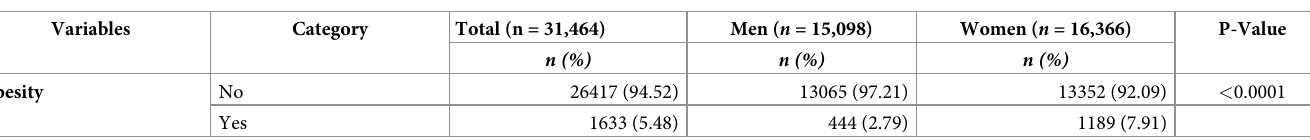
women had multimorbidity, while only 22% of men had multimorbidity. The prevalence of depression in older men was 26.2% while among older women this was around 31.4 percent.